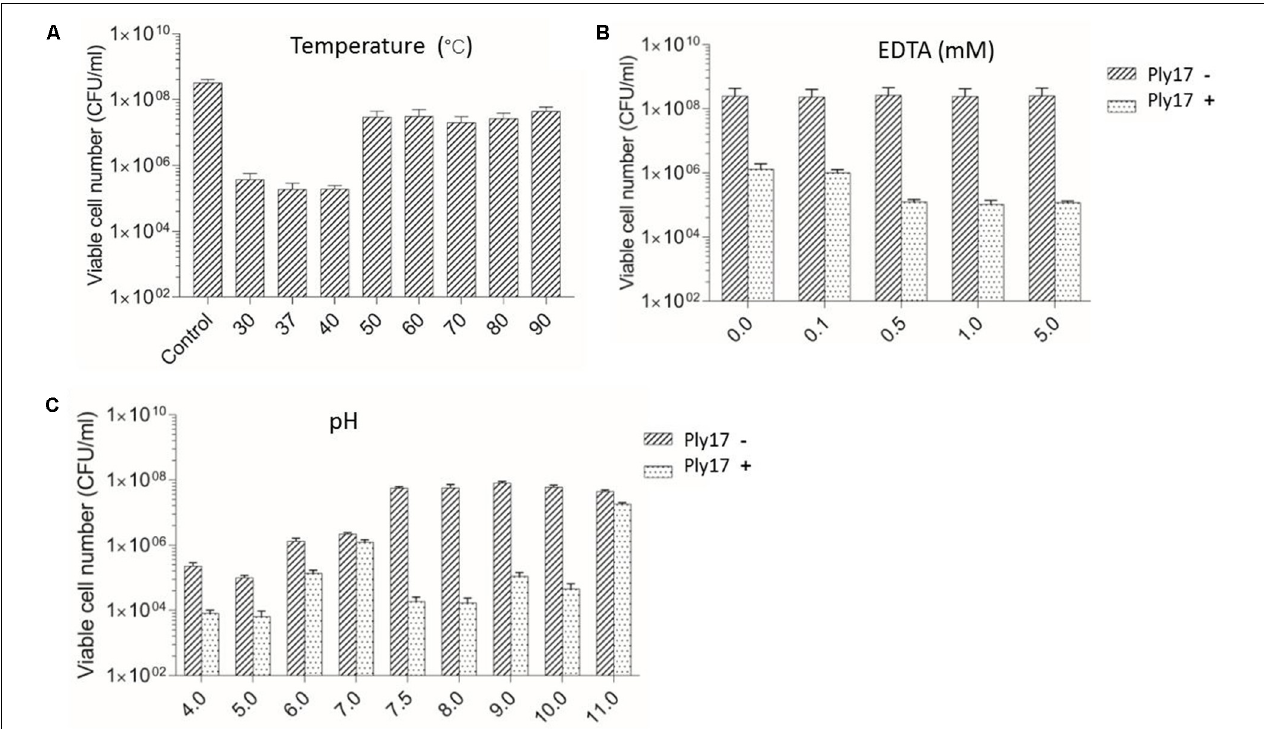
FIGURE 3 | Lytic activity of Ply17 against PAO1 under different conditions. The antimicrobial activity of Ply17 on 0.1 M EDTA-treated PAO1 was performed at different temperatures (A) , EDTA concentrations (B) , and pH values (C) . EDTA displays a synergistic effect with Ply17 in killing PAO1 (B) . The best lytic activity was observed at 37 ◦ C, pH 7.5, in the presence of 0.5 mM EDTA.